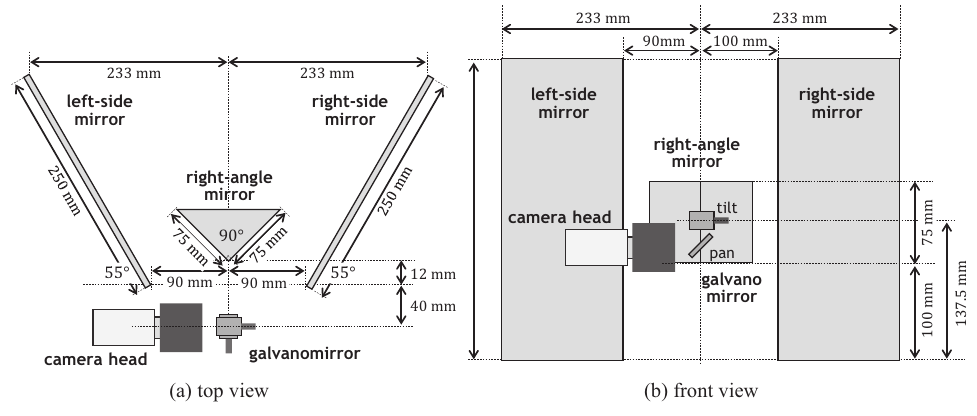
Figure 7. Arrangement of mirror system: ( a ) top view; ( b ) front view. The right angle mirror and the two side mirrors can cover the view angle of the camera view completely when the pan and tilt angles of the galvano-mirror were in the range of − 10 to 10 degrees, whereas the camera view involved the left-side and right-side views, which were split by the right-angle mirror, when the pan angle of the galvano-mirror was around zero; the camera view only involved the left-view image via the left-side mirror or the right-view image via the right-side mirror, when the pan angle was in the range of − 10 to − 2 degrees or in the range of 2 to 10 degrees, respectively. It is assumed that the reference positions of the virtual left and right pan-tilt cameras were set when the pan and tilt angles of the galvano-mirror were − 5 and 0 degrees, and 5 and 0 degrees, respectively. Figure 8 illustrates the locations of the virtual left and right pan-tilt cameras. The optical centers and the normal direction vectors of the optical axes of the virtual left and right cameras at their reference positions were ( − 152 mm, 10 mm, − 105 mm ) and ( 0.174, 0.000, 0.985 ) , and ( 152 mm, 10 mm, − 105 mm ) and ( − 0.174, 0.000, 0.985 ) , respectively; the xyz -coordinate system was set so that its origin was set to the center of the pan mirror of the galvano-mirror as illustrated in Figure 8. The virtual left and right pan-tilt cameras can change their virtual pan and tilt angles around their reference positions in the range of − 10 to 10 degrees and in the range of − 20 to 20 degrees, respectively, which corresponded to twice of the movable ranges of the pan and tilt angles of the galvano-mirror for each virtual pan-tilt camera, whereas the view angle of the camera view was 8.28 degrees in both the pan and tilt directions, respectively, which were determined by the focal distance f = 50 mm of the CCTV lens and the 5.12 × 5.12 mm size of the image